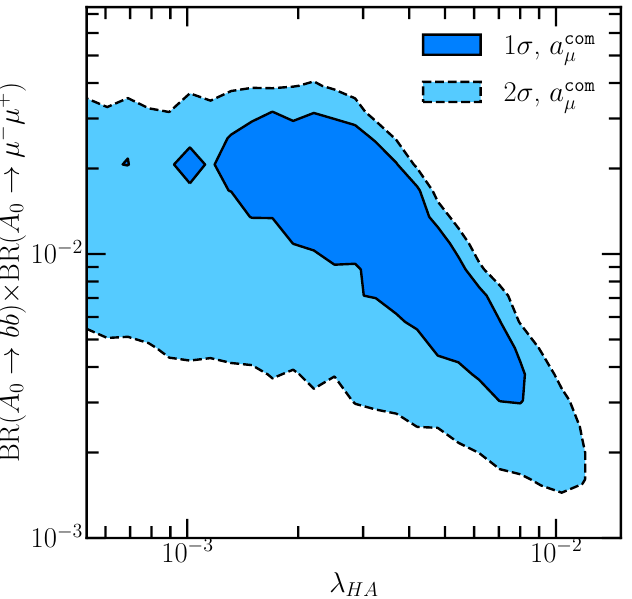
Figure 4 . The two dimensional likelihood contour in the plane ( λ HA , BR( A 0 → bb ) × BR( A 0 → µ + µ − ) ). Colors and constraints are as described in figure